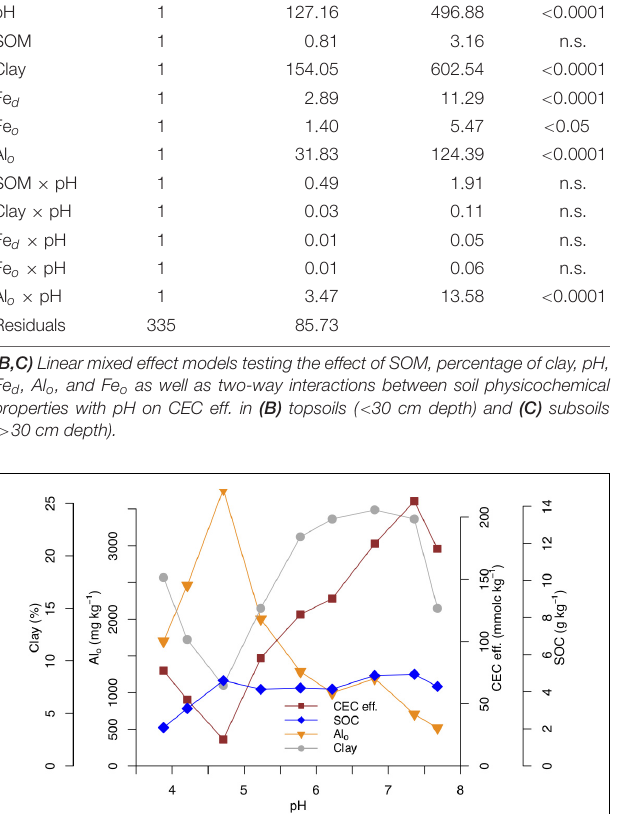
FIGURE 4 | Median values of effective cation exchange capacity (CEC eff., brown squares), soil organic carbon (SOC, blue diamonds), oxalate extractable Al (Al o , orange triangles) and clay content (gray circles), across pH classes in subsoils ( > 30 cm depth) of Swiss forests.